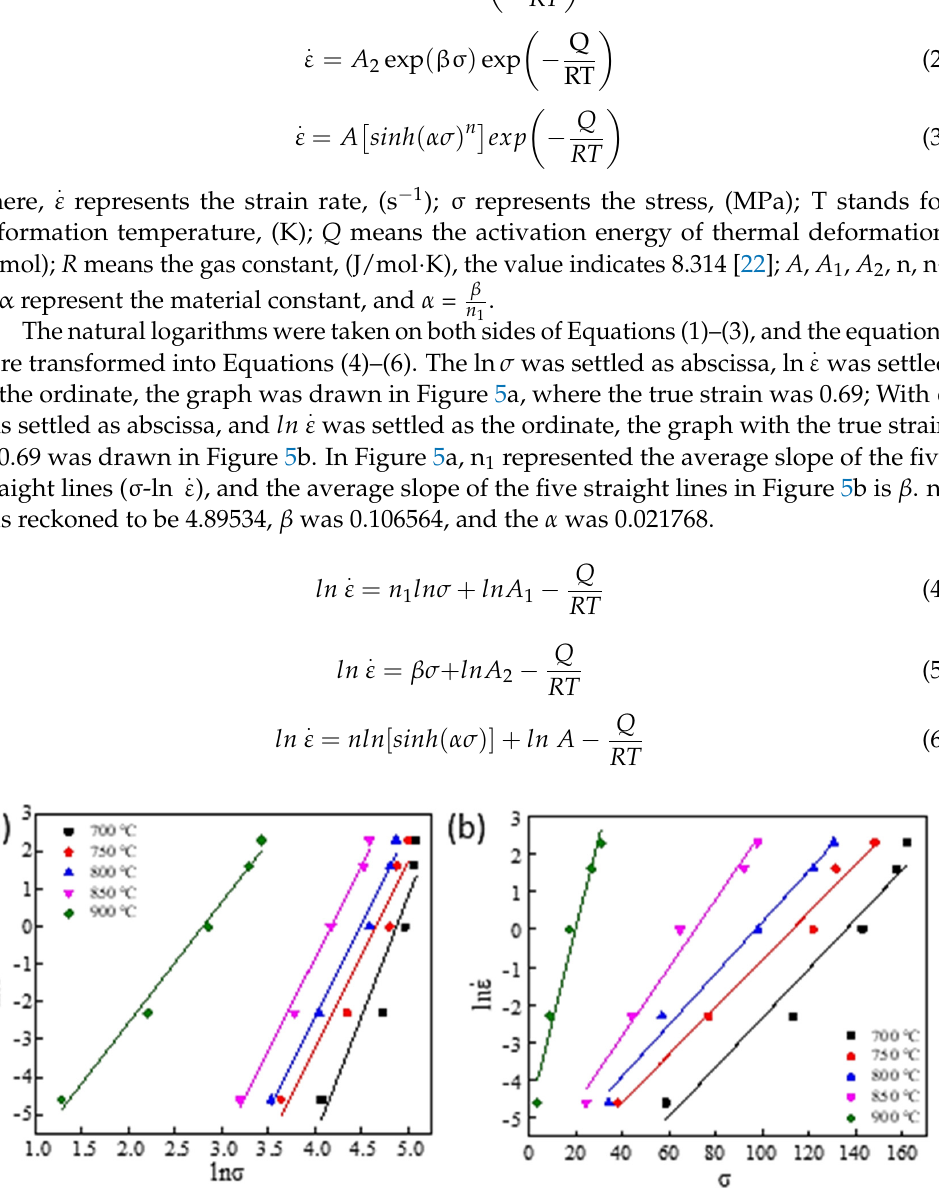
. ε − . ε Figure 5. Relationship between( a ) lnε(cid:4662) − ln𝜎 , ( b ) σ −lnε(cid:4662) . Figure 5. Relationship between ( a ) ln ln σ , ( b ) σ − ln The relationship of 𝑙𝑛[𝑠𝑖𝑛 ℎ(𝛼𝜎)] − 𝑙𝑛 𝜀(cid:4662) is drawn into a curve in Figure 6a. The aver- age n of the straight-line slope of ln[sin h(ασ)] was calculated, which was 2.982678. In a certain range, the activation energy of thermal deformation is determined when the strain rate 𝜀(cid:4662) is certain. The partial derivative of 1/T on both sides of equation (6) was calculated, expressed as [23]: 𝑄 = 𝑅𝑛 𝜕 𝑙𝑛[ 𝑠𝑖𝑛ℎ( 𝛼𝜎)] 𝜕(1 𝑇 ) (7) Figure 6. Relationship between ( a ): 𝑙𝑛 𝜀(cid:4662) − 𝑙𝑛[𝑠𝑖𝑛 ℎ(𝛼𝜎)] , ( b ): 𝑙𝑛[𝑠𝑖𝑛 ℎ(𝛼𝜎)] − 1000/T(K − 1 ). Figure 6b shows the relation curve of 𝑙𝑛[𝑠𝑖𝑛 ℎ(𝛼𝜎)] − 1000/T when the true strain was 0.69. Under different strain rates, the average straight-line slope value was 16.55988, which was substituted into Equation (7) to reckon the thermal deformation activation en- ergy ( Q ), which was 410.655 kJ/mol. In general, when characterizing the impact of temperature and strain rate on the de- formation behavior of materials, the Zener-Holloman parameter of temperature-compen- sated strain rate factor is often used in Equation (8) [24]. 𝑙𝑛 𝑍 = 𝑙𝑛 𝐴 + 𝑛 𝑙𝑛[ 𝑠𝑖𝑛ℎ( 𝛼𝜎)] (8) According to Equation (3): 𝜀(cid:4662) 𝑒𝑥𝑝( 𝑄 𝑅𝑇) = 𝐴[𝑠𝑖𝑛ℎ(𝛼𝜎)] (cid:3041) (9)